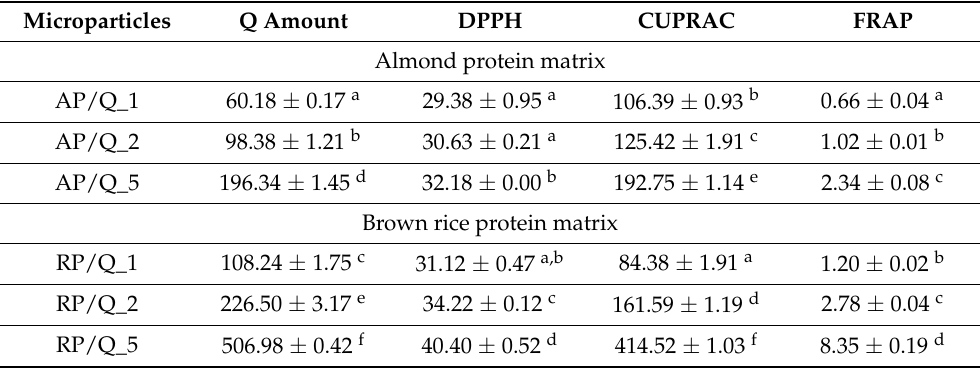
Table 1. Amount of quercetin (mg/100 g) and antioxidant activity ( µ mol TE/100 g) of pro- tein/quercetin